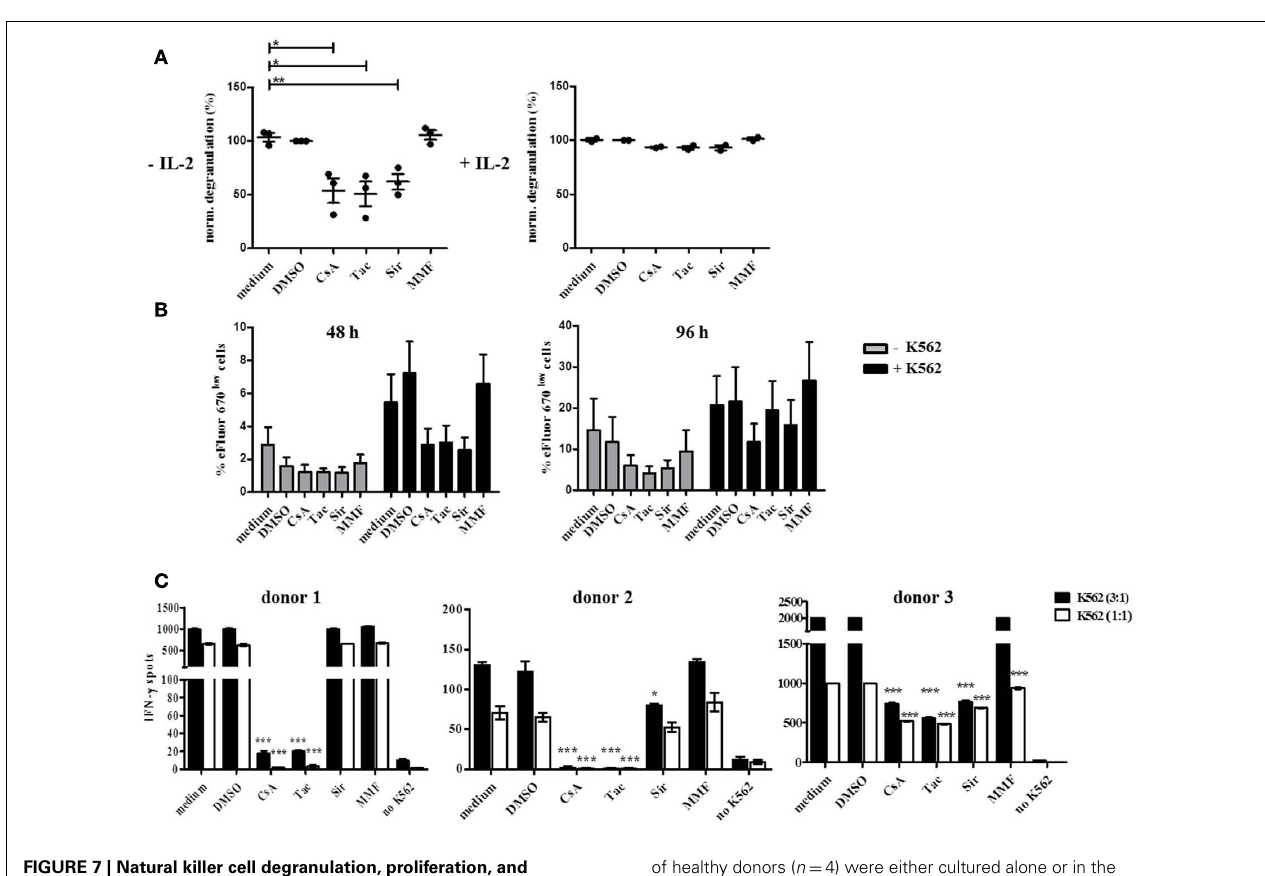
FIGURE 7 | Natural killer cell degranulation, proliferation, and IFN- γ production is differentially inhibited by CsA,Tac, Sir, or MMF treatment and this effect is counterbalanced by IL-2. (A) Resting ( − IL-2, n = 3) or 48h pre-activated PBMC (500U/ml IL-2, n = 2) of healthy donors were stimulated by plate bound CD16 Ab in the presence of CsA, mTORi, or MMF (10 µ M), DMSO control solvent or medium. Degranulation was measured after 4h by CD107a-staining of CD3 − CD56 + NK cells. Baseline degranulation with isotype Ab reached < 5% of resting and < 26% of IL-2 activated NK cells (data not shown). (B) eFluor 670 stained PBMC